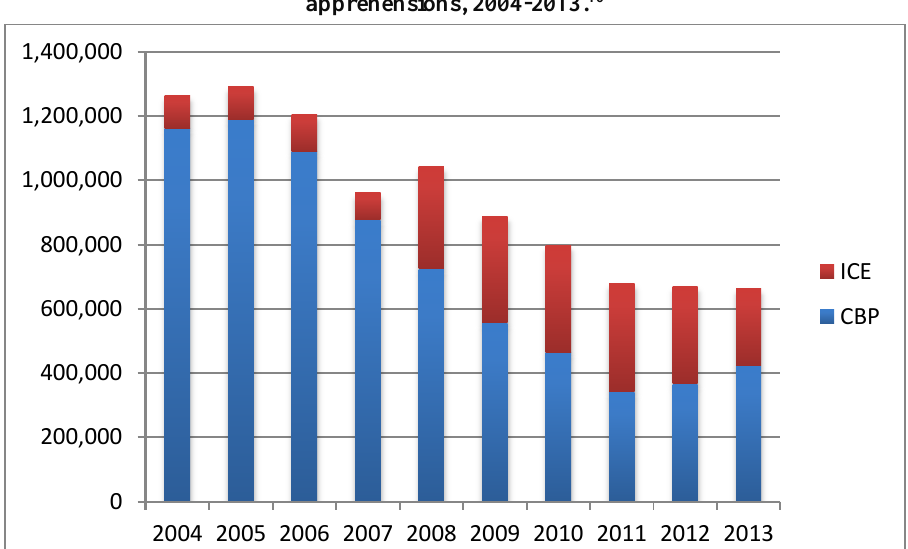
Figure 4: Immigration and Customs Enforcement (ICE) versus Customs and Border Patrol (CBP) apprehensions, 2004-2013.